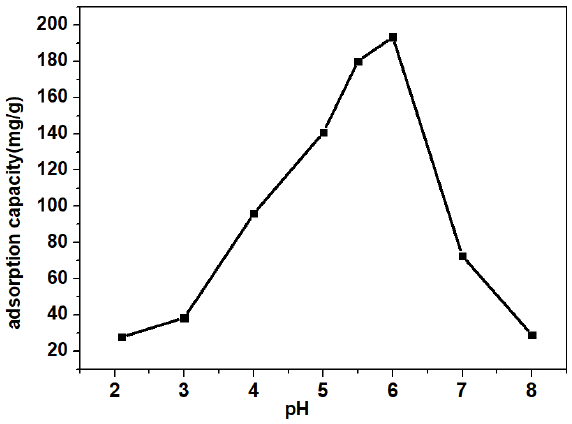
Figure 3. Effect of initial pH on magnetic biochar (adsorption time: 18 h).